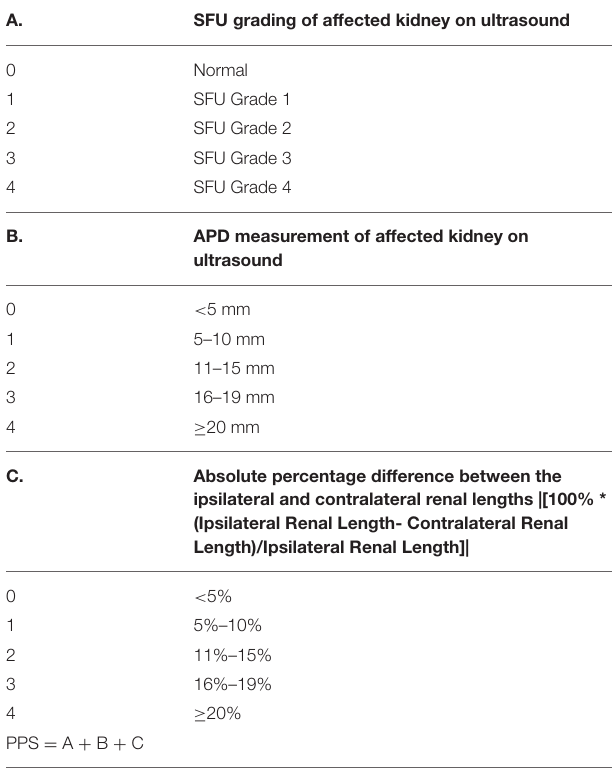
TABLE 1 | The Pyeloplasty Prediction Score is based on three parameters: society of fetal urology (SFU) grade of the ultrasound, transverse anteroposterior diameter (APD) measurement, and the absolute percentage difference between the lengths of the ipsilateral and contralateral kidneys.